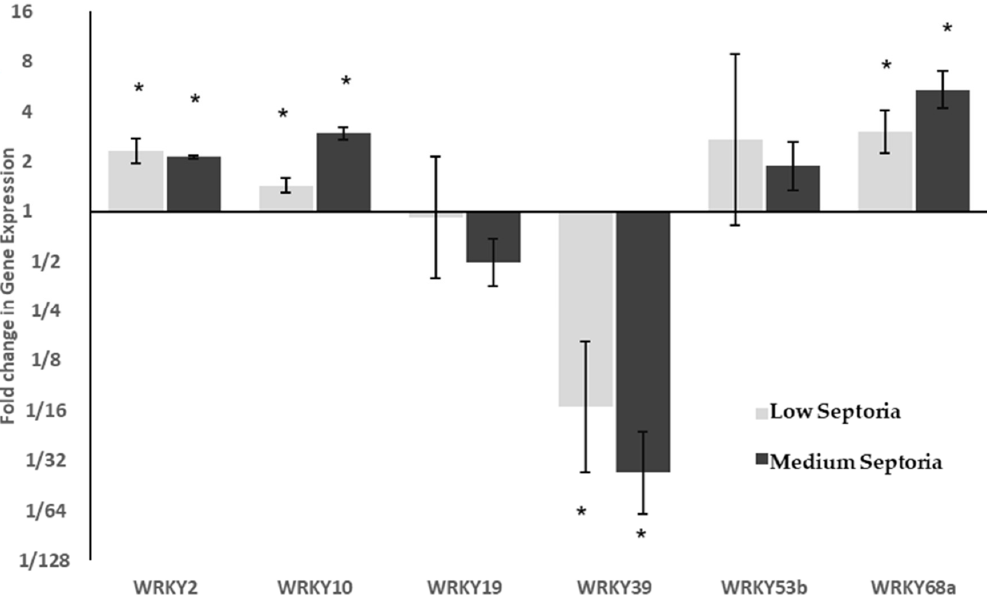
Figure 3. Relative expression of WRKY transcription factors in response to Septoria Leaf Blotch. ∆ C T values were analysed using ANOVA followed by Tukey post-hoc. * p < 0.05 in post-hoc analysis. Changes in expression were compared to plants showing Very Low symptoms of SLB. WRKY39 shows significant downregulation, whilst WRKY68a shows a dose dependent increase in expression with increasing SLB severity.